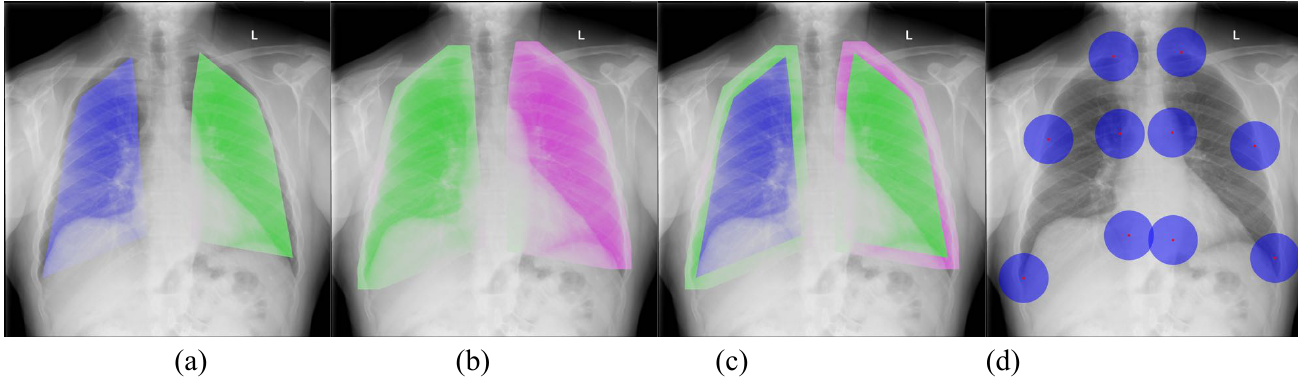
Figure 9. Visualization of region of interest in image quality evaluation. From left to right ( a ): inner lung region ( R l ( b ): outer lung region( R l o and R r o ); ( c ) overlapping between inner and outer lung regions; and ( d ): area around landmark points ( R i p , i ∈ [ 1,..,10 ]